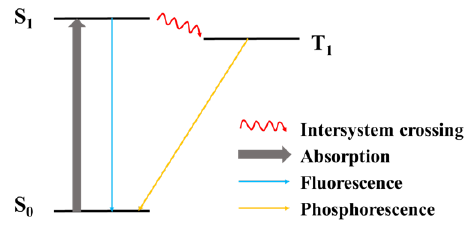
Figure 10. Jablonski diagram of fluorescence and phosphorescence.